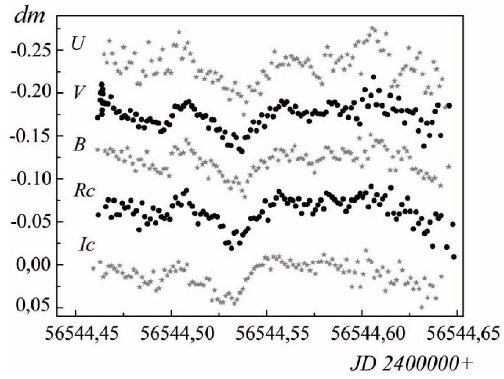
Figure 3: The LCs after removal of the declining trend in brightness during the outburst, on September, 8, 2013. The LCs are displaced by arbitrary